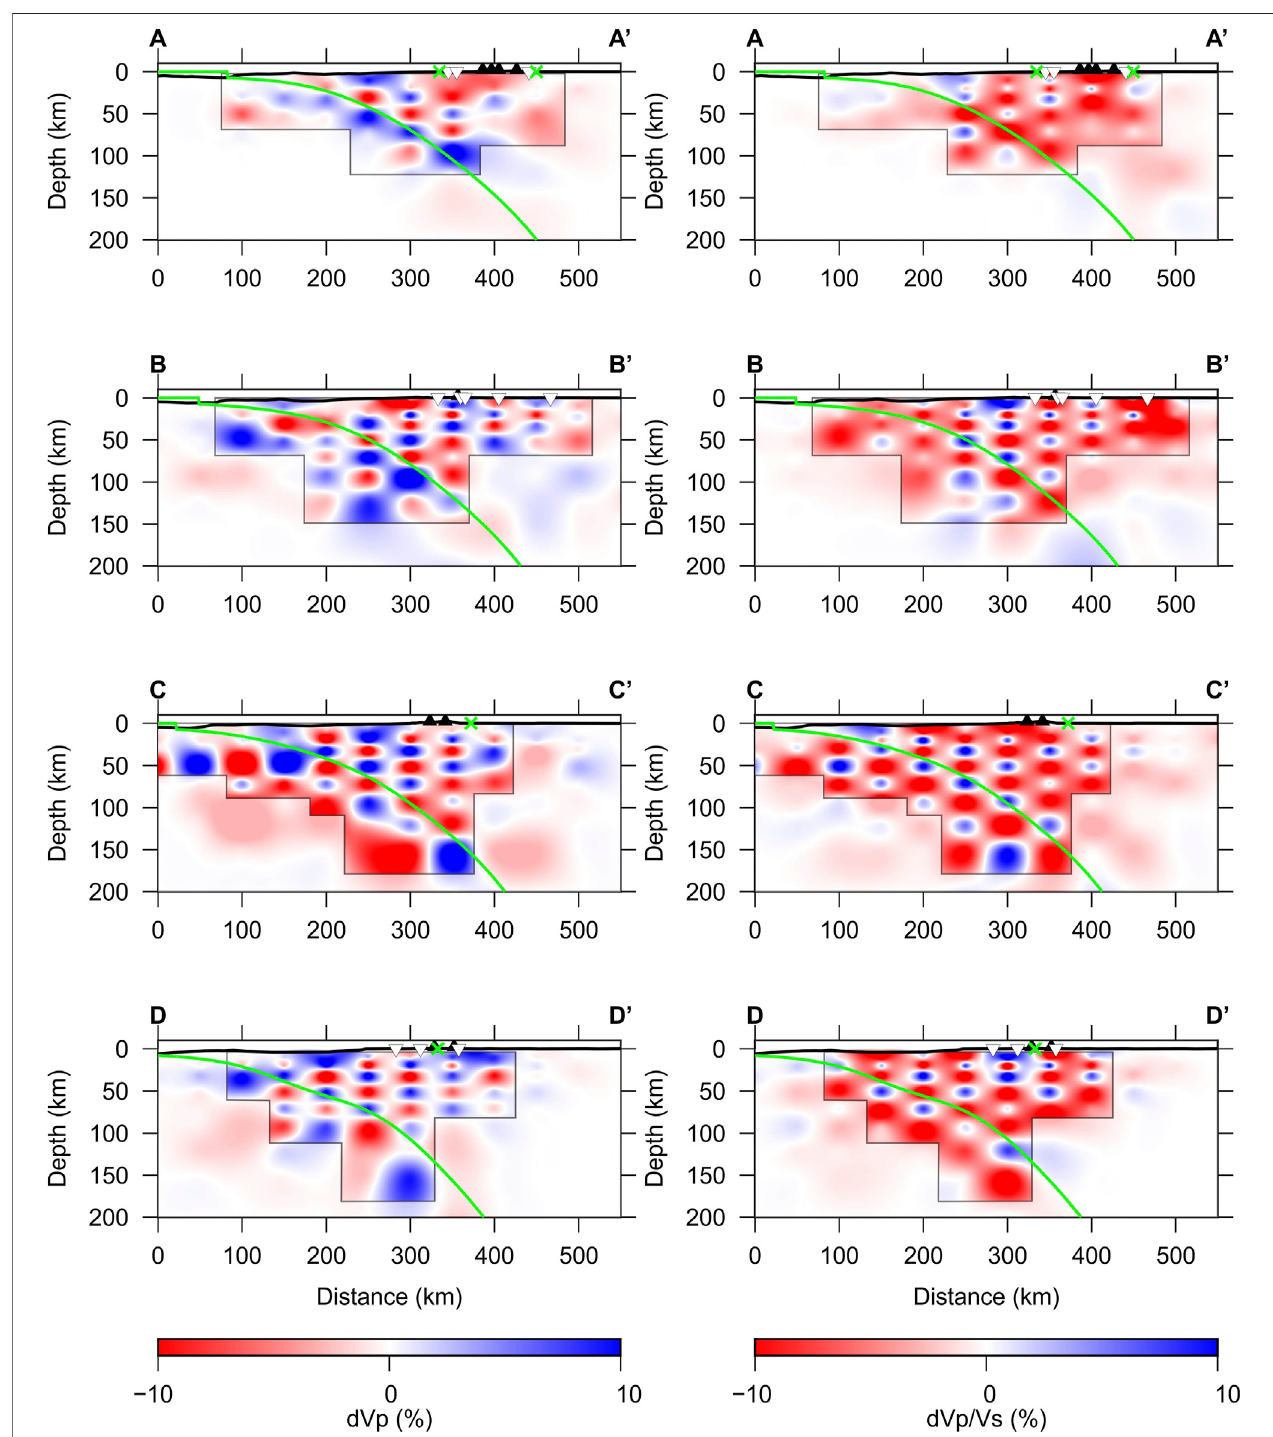
FIGURE 3 | Results of checkerboard resolution test for Vp and Vp/Vs ratio in vertical direction across Mt. Merapi-Merbabu (A-A 9 ) , Mt. Wilis-Pandan (B-B 9 ) , Mt. Semeru-Bromo (C-C 9 ) , and Mt. Ijen-Baluran (D-D 9 ) . Green lines and crosses indicate the slab 2.0 model (Hayes et al., 2018) and faults, respectively. Black triangles show locations of